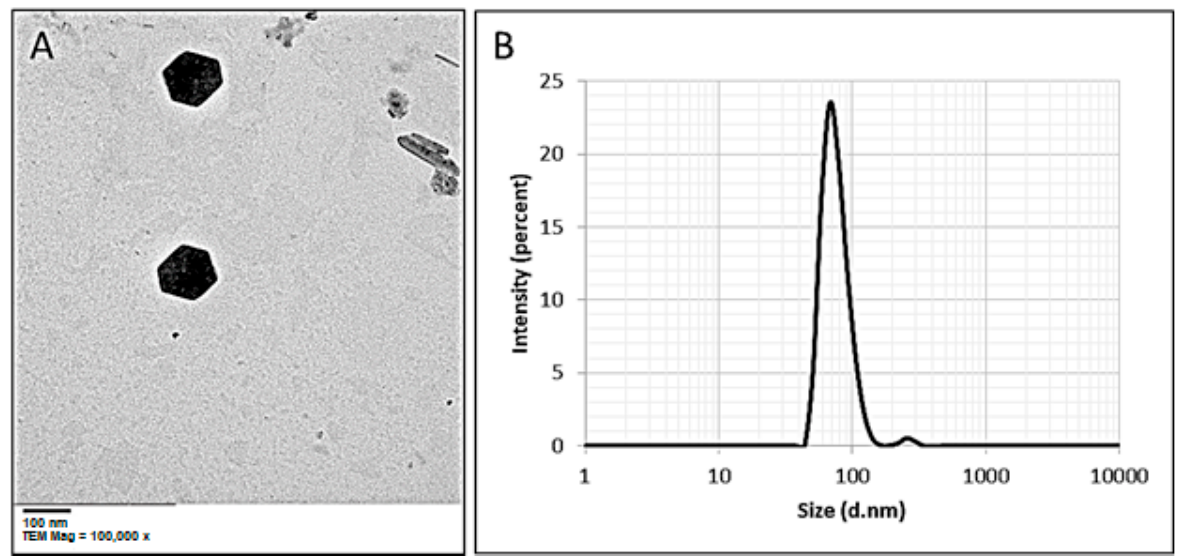
Figure 5. TEM image for Hem-NPs showing hexagonal shapes ( A ) and DLS analysis of the biosyn- 310 thesized Hem-NPs ( B ) . thesized Hem-NPs ( B